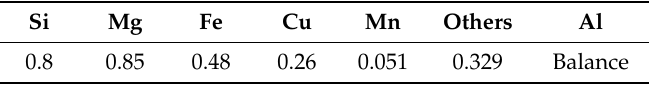
Table 1. Chemical composition of aluminum alloy